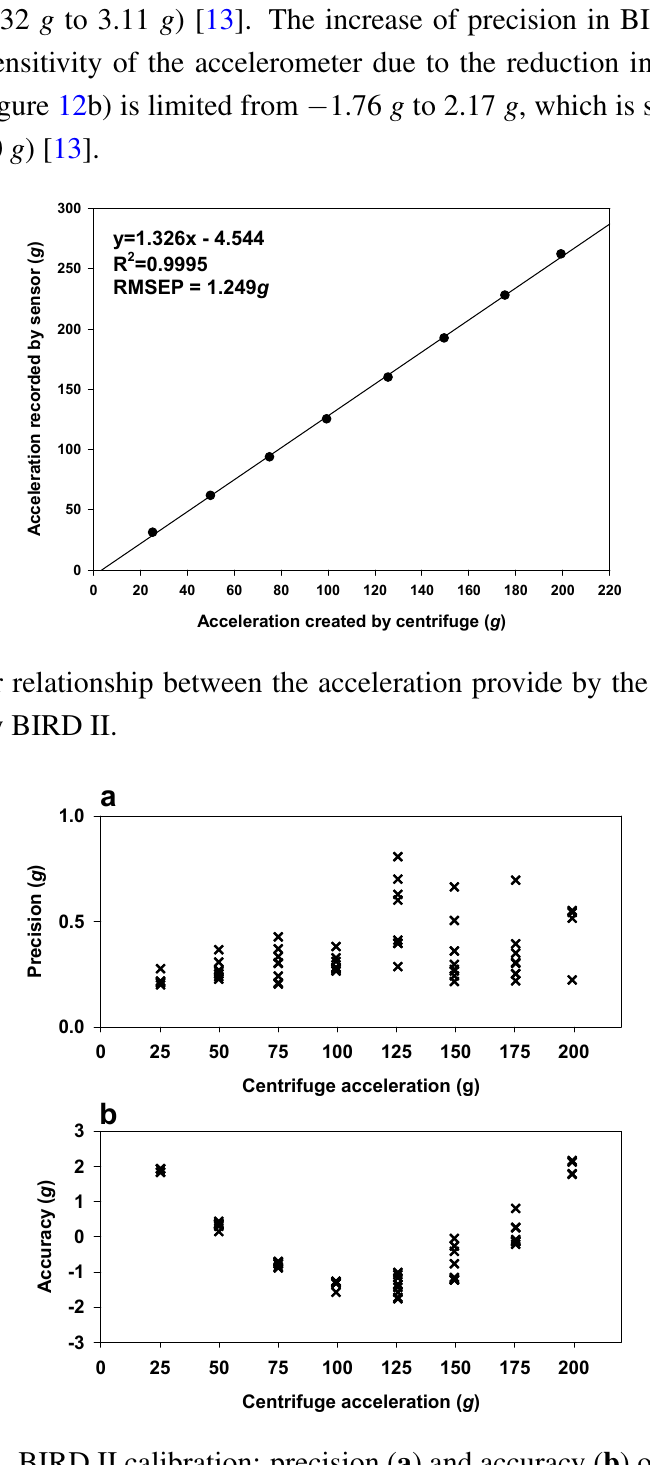
Figure 12. BIRD II calibration: precision ( a ) and accuracy ( b ) of BIRD